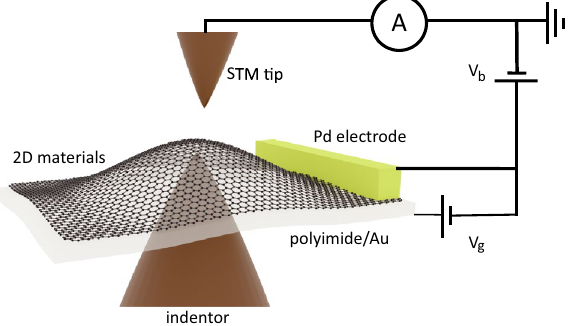
Figure 1. The schematic of strain- and gate-controllable STM structure. V b and V g are bias and gate voltages applied on the sample,